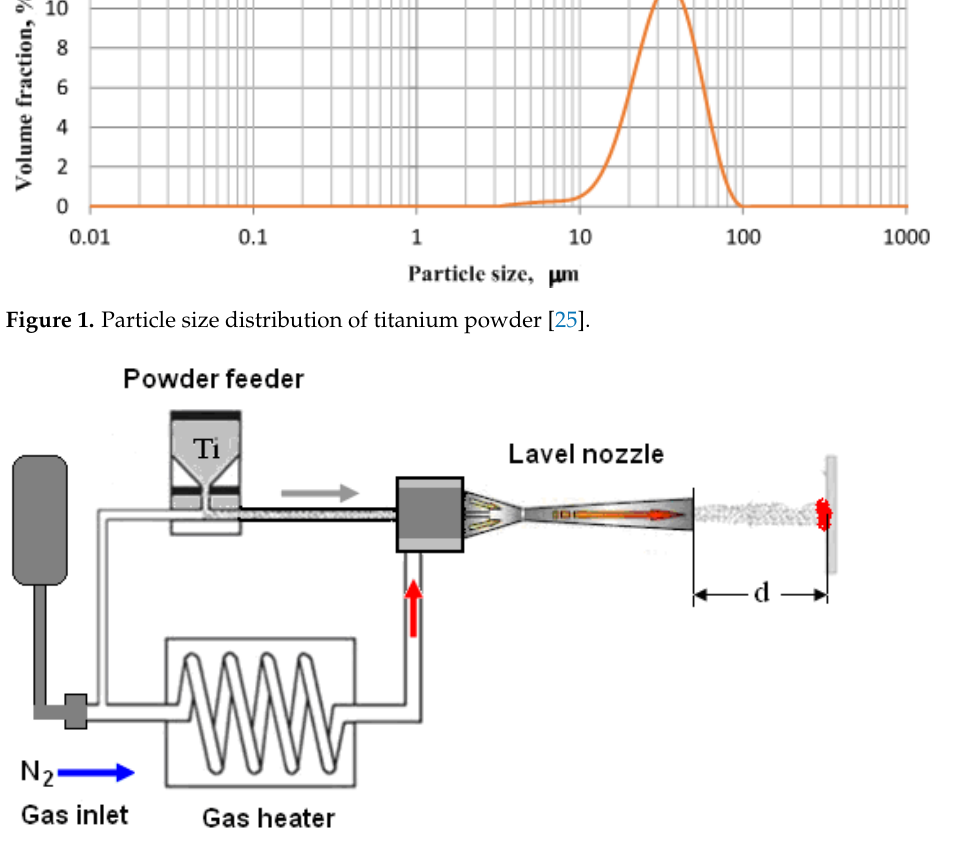
Figure 1. Particle size distribution of titanium powder [25].